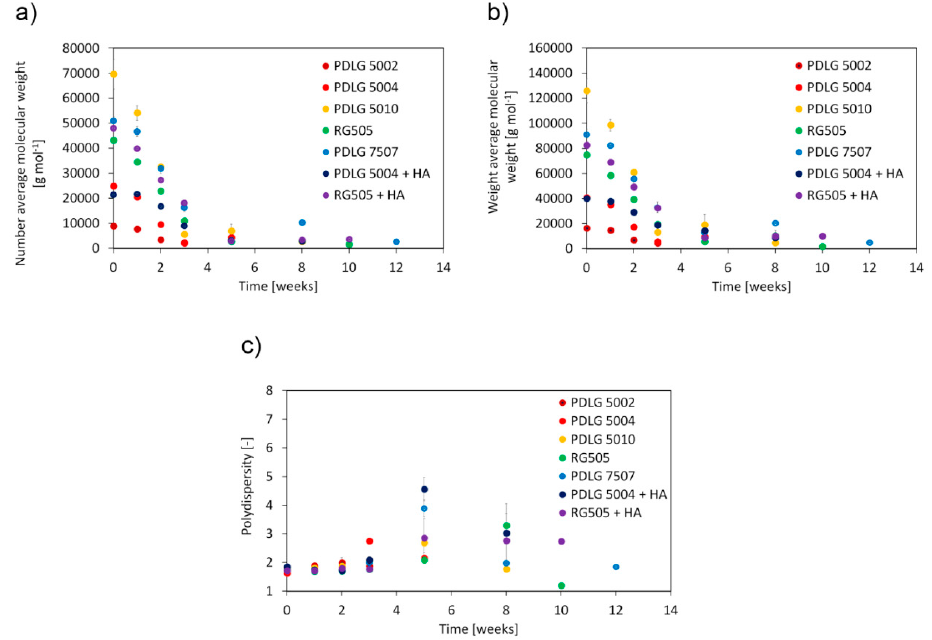
Figure 2. Number ( a ) and weight ( b ) average molecular weights and polydispersity ( c ) as a function of degradation time; values are expressed as arithmetic average of three independent measurements ± standard deviation.